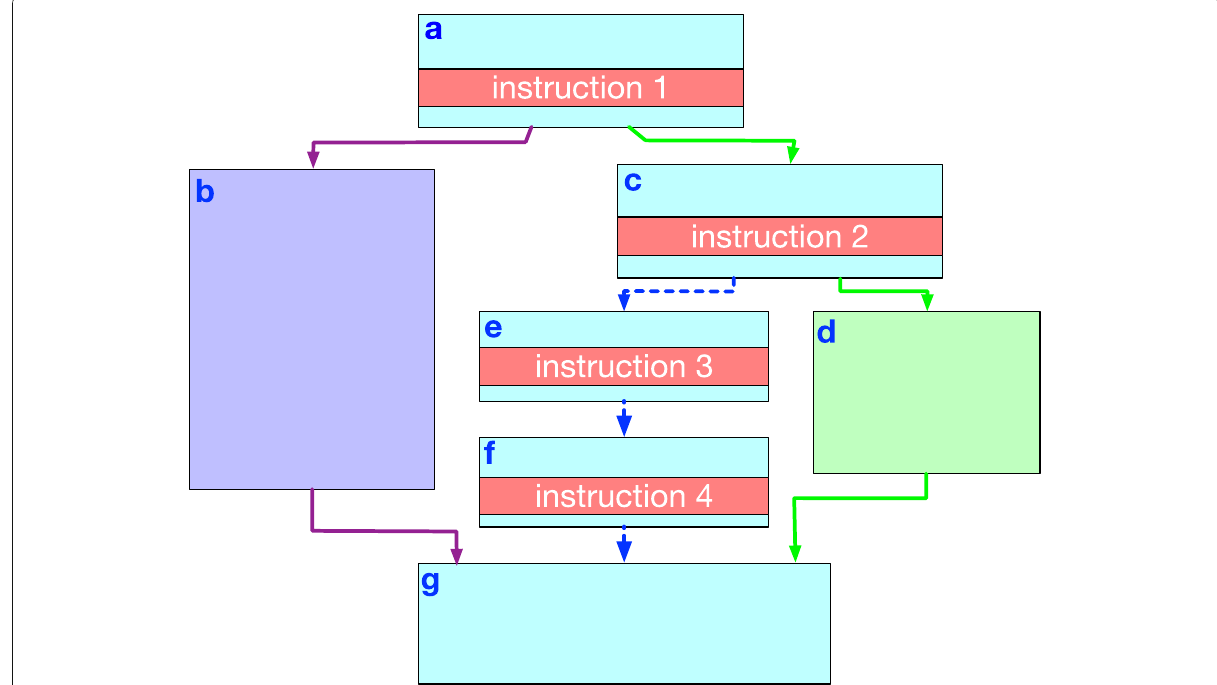
Fig. 5 An example layout-contributor slice. Compared to the path a=>b, the path a=>c=>d has a longer prefix with the target slice in the path